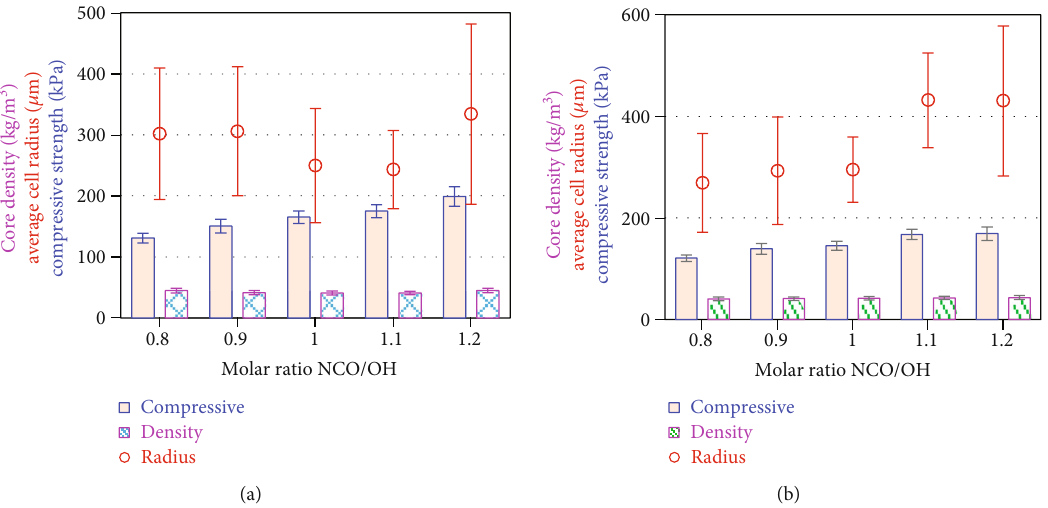
Figure 7: Dependence of properties of foams (a) 0.35 and (b) 0.25wt.% L580 on the NCO/OH ratios.